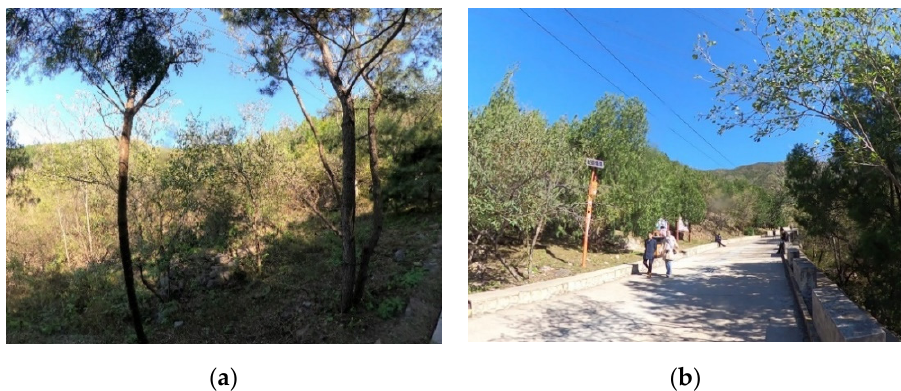
Figure 1. The map of research sites and main tour routes in each forest park.